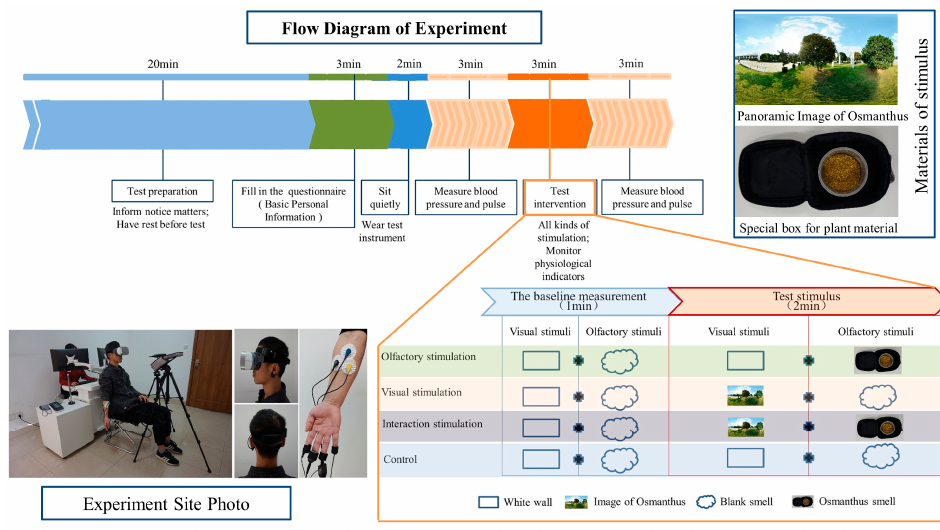
Figure 1. Experimental